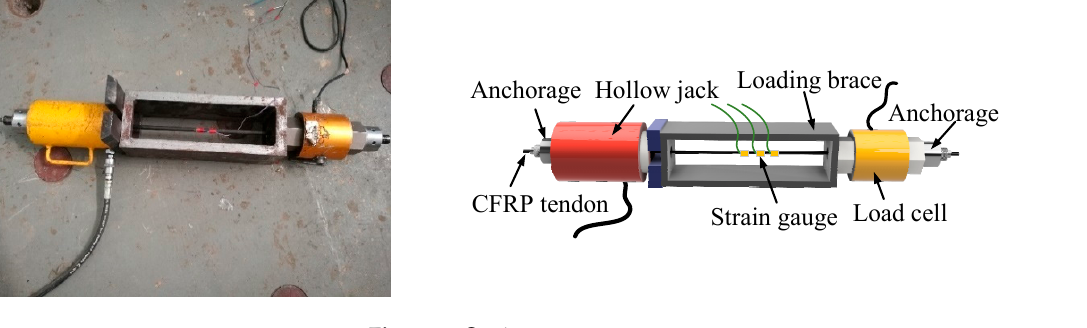
Figure 2. Static test setup.